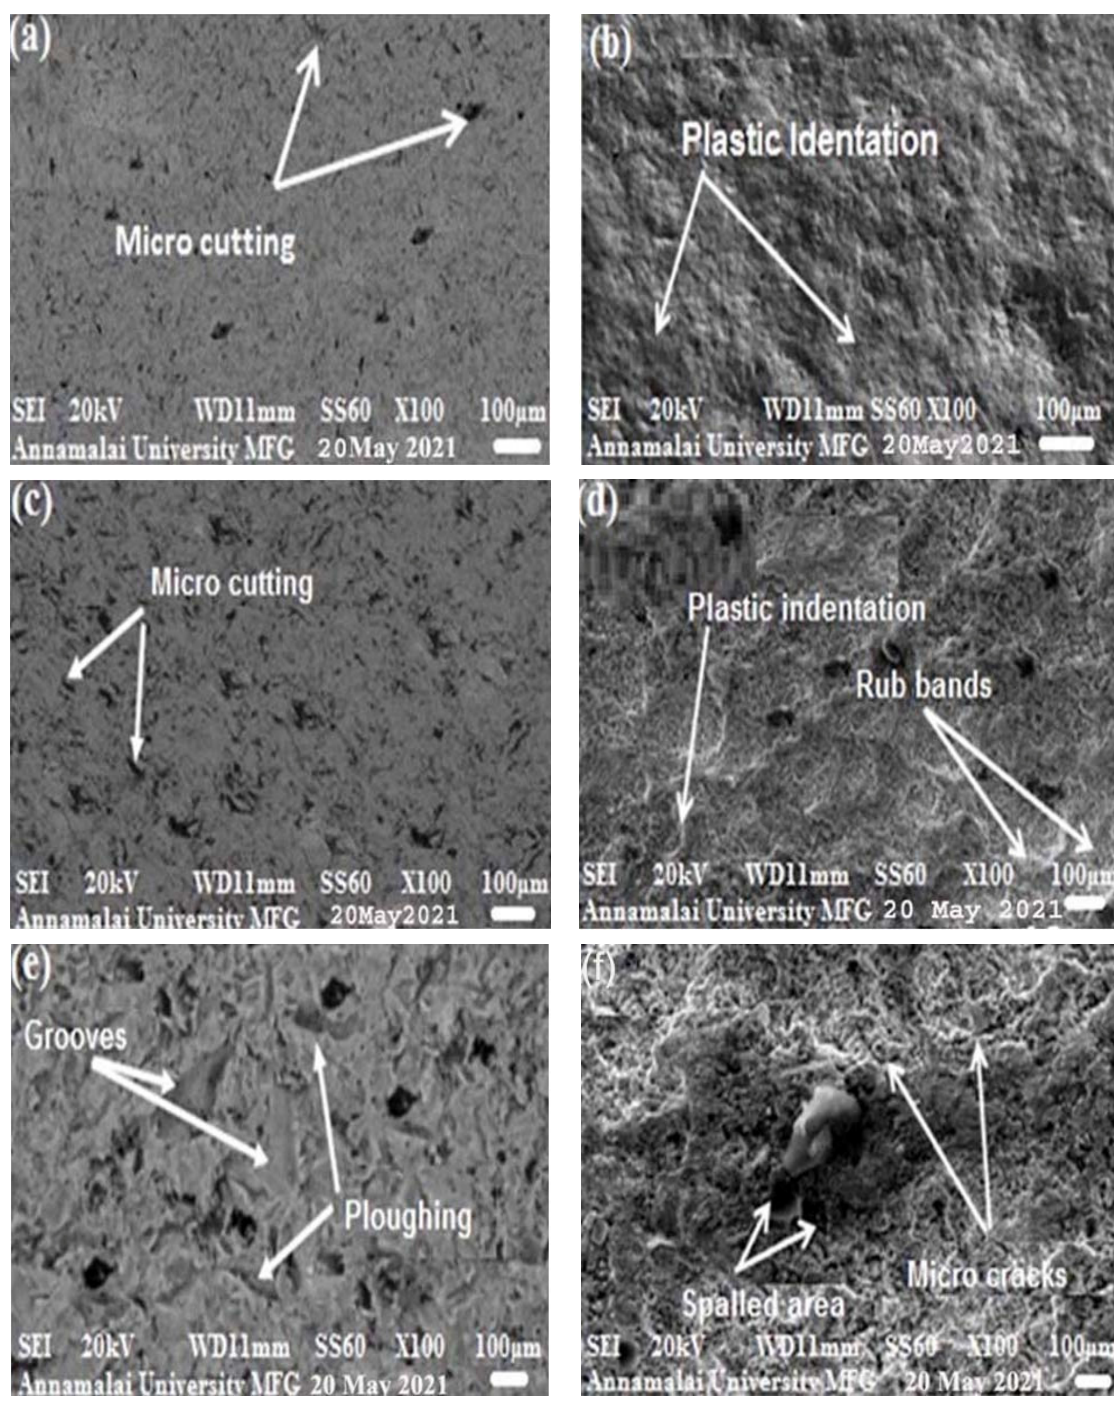
Figure 6. Worn surfaces of the coatings and substrate under different impact angles: ( a , c , e ) uncoated substrate; ( b , d , f ) coatings.